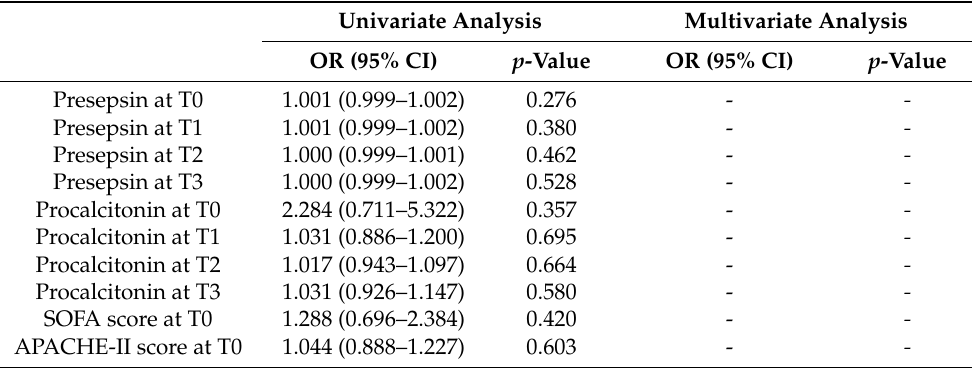
Table 12. Risk factors associated with postoperative sepsis within 7 days after surgery in severe-AKI group (stage 3 with